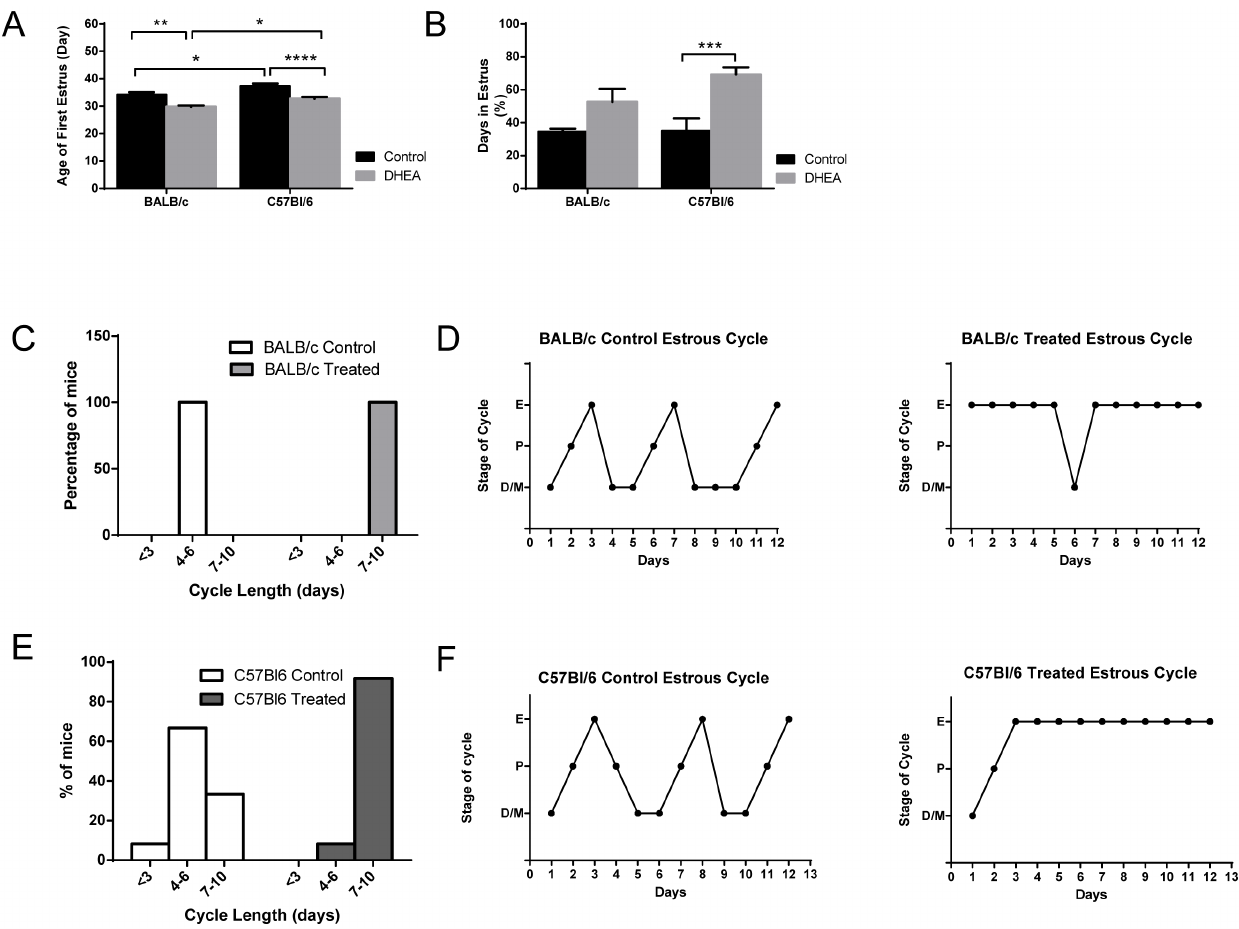
Figure 4. DHEA advances puberty and disrupts the estrous cycle in both strains. A. Day of life when first estrous smear was recorded. B. Percentage of days in estrus stage during the 20 day experiment. C. Average cycle lengths for BALB/cByJ females. n=8 D. Representative estrous cycles of BALB/c females, untreated and treated. n=6–8 E. Average cycle lengths for C57Bl6 females. n=12–13 F. Representative estrous cycles of C57Bl6 females, untreated and